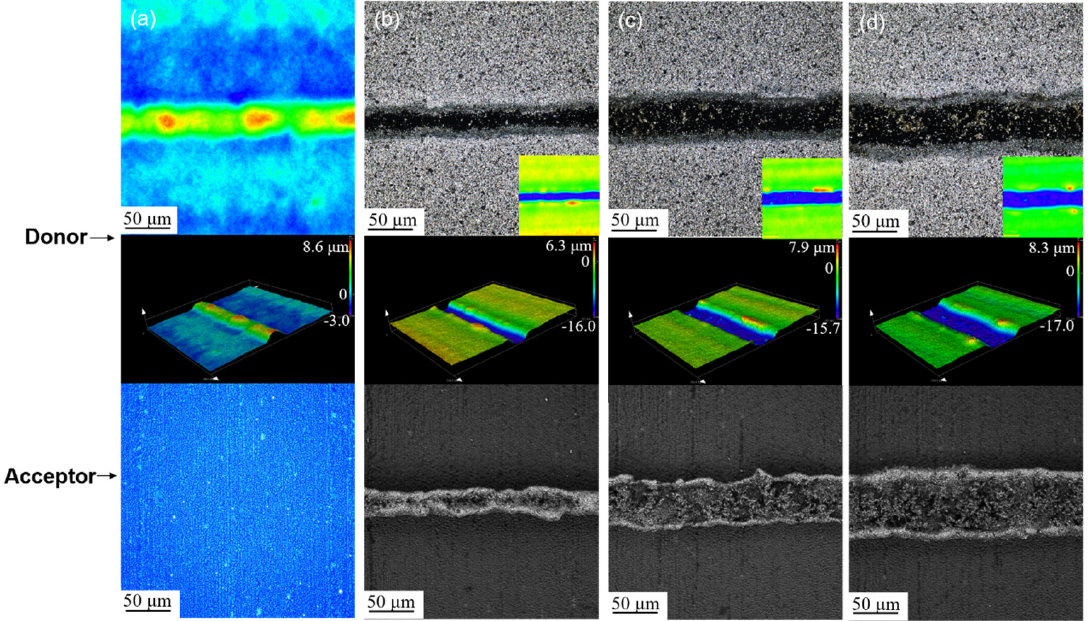
Figure 8. Geometric morphology of the silver paste remaining on the donor and the formed lines (unsintered) on the acceptor, obtained by LSCM. ( a ) below critical threshold, ( b ) critical transfer threshold, ( c ) above critical threshold, ( d ) much higher than critical threshold. Table 2. Width and height of the protrusion and formed line on the donor and acceptor under different laser fluences.